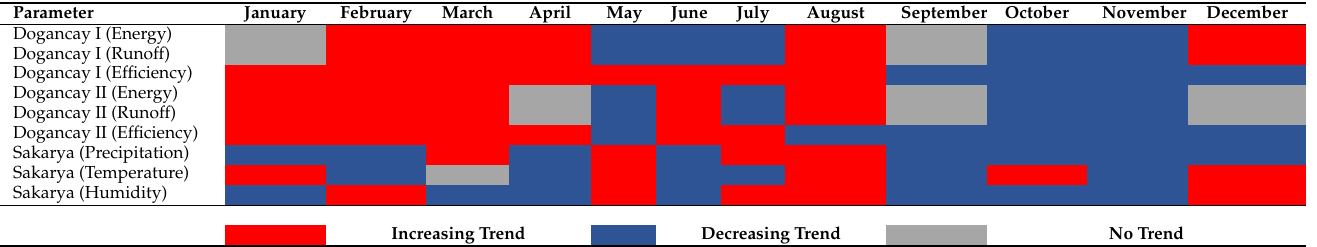
Table 3. General Evaluation of Standard Deviation Analysis Results for Each